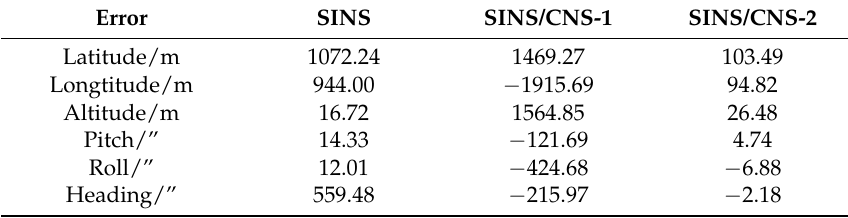
Table 4. The near-Earth vehicle navigation errors at the end of flight (unit: